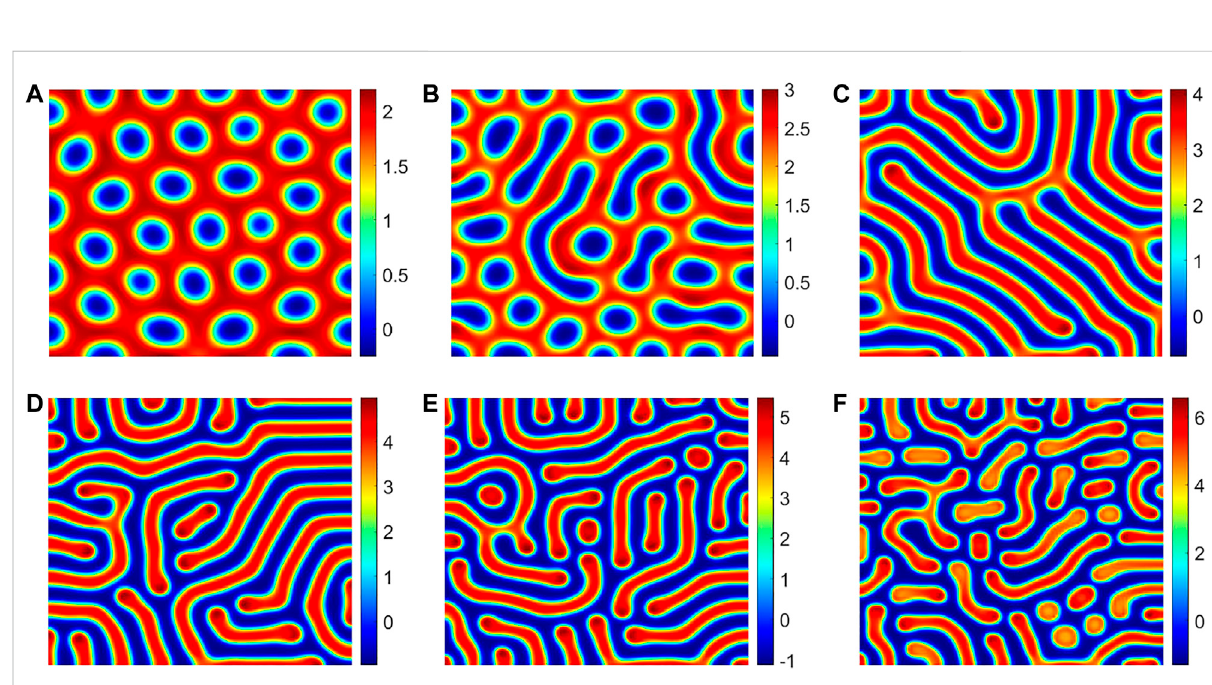
FIGURE 6 Different values of the parameter d correspond to different vegetation patterns, (A) d = 1.52, (B) d = 2.34, (C) d = 3.81, (D) d = 5.86, (E) d = 7.23, and (F) d = 9.56. The other parameter values are a = 3.25, m = 1.5, d 1 = 1, and d 2 =